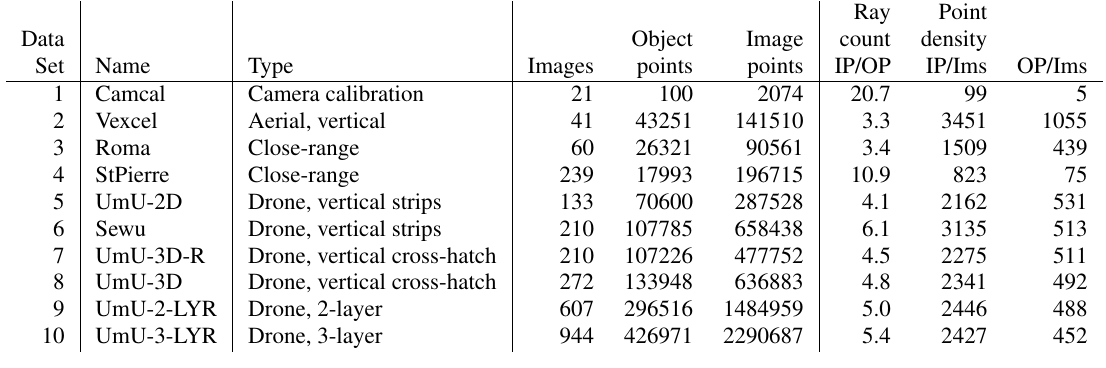
Table 1: Statistics for the data sets used in the